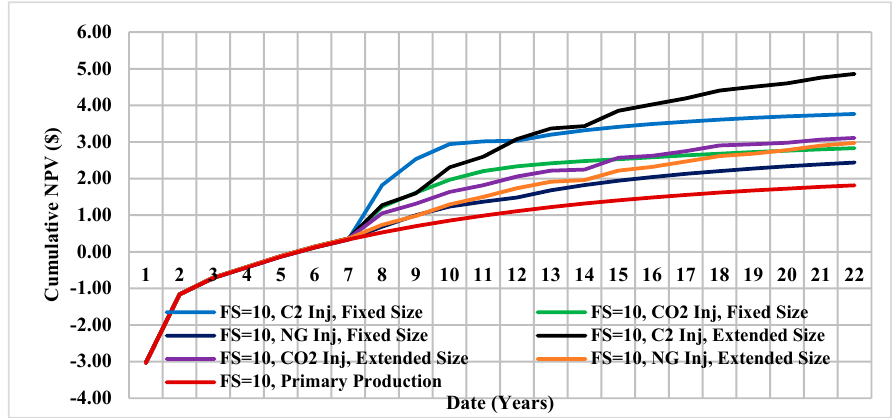
Figure 24. NPV of the scenarios for fixed and extended cycles of cyclic CO2, C2 and NG injection as well as natural depletion, FS = 10, Oil API = 38.